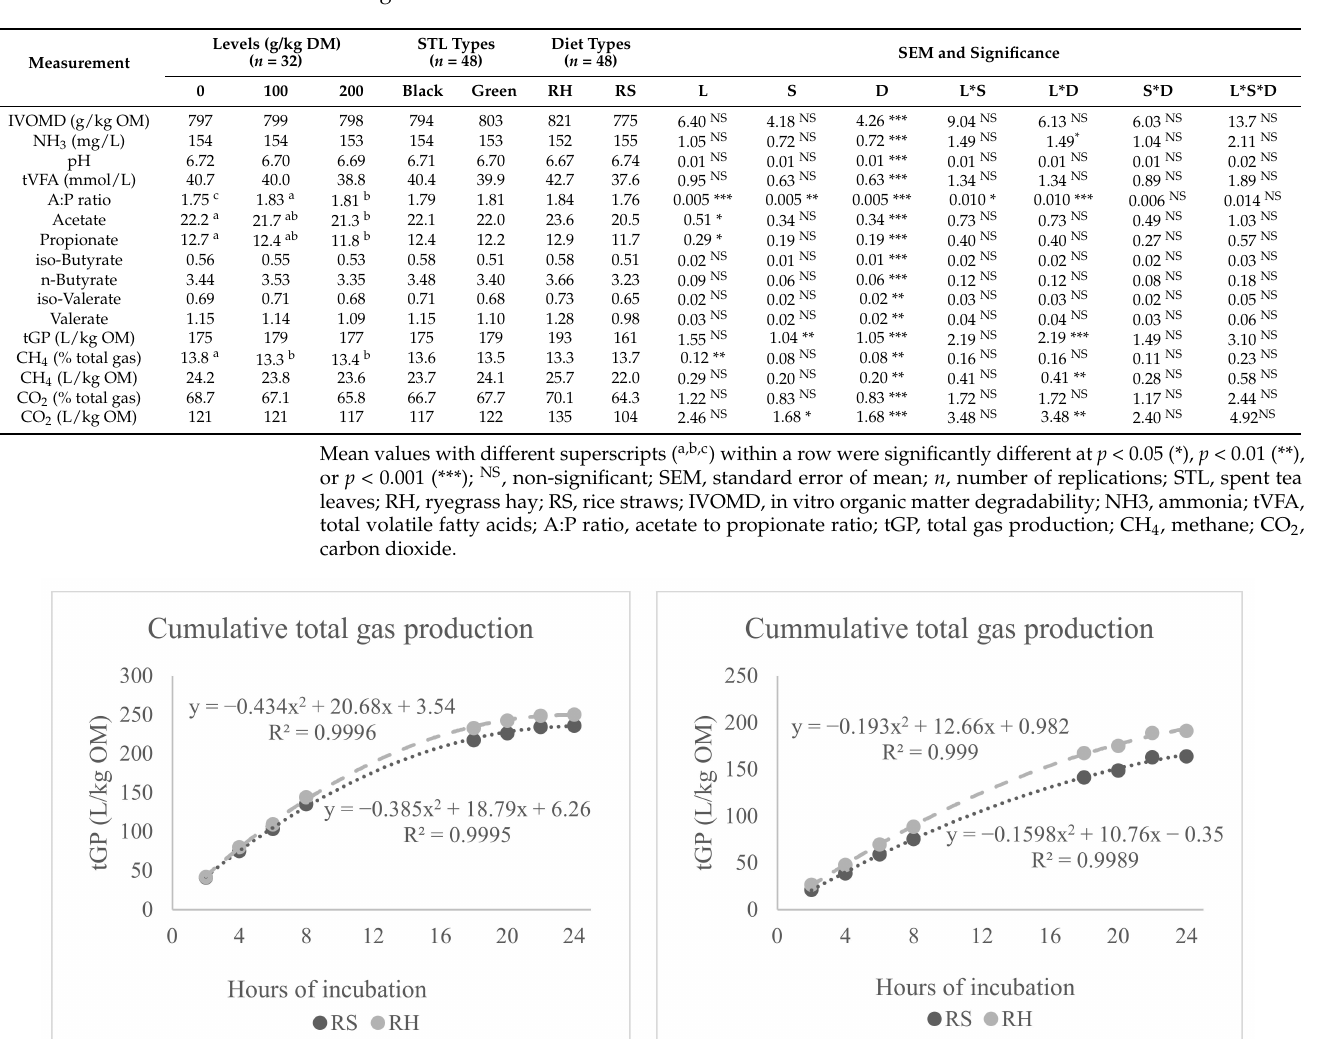
Table 6. Mean values of rumen in vitro measurements at 24 h incubation time for the main effect of inclusion levels (L, g/kg DM), STL types (S), diet types (D) and their interactions with SEM and significance.